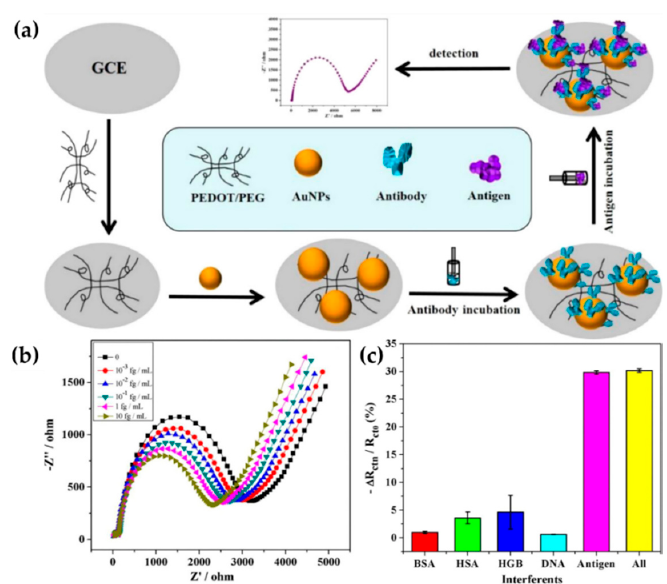
Figure 9. ( a ) Schematic illustration of of α -fetoprotein (AFP) biosensor synthesis; ( b ) impedance spectra corresponding to the biosensor with different antigen concentrations (0.01-M PBS, pH 7.4), curves from inner to outer represent 10 fg/mL, 1 fg/mL, 10 − 1 fg/mL, 10 − 2 fg/mL, 10 − 3 fg/mL AFP antigen, respectively; ( c ) responses of the AFP biosensor to bovine serum albumin (BSA) (1.0 nM), human serum albumin (HSA) (1.0 nM), hemoglobin (HGB) (1.0 nM), DNA sequence (1.0 nM), AFP antigen (1.0 fg/mL) and a mixture of all the above substances, respectively. Adapted with permission from reference [41]. Copyright © 2016 Elsevier B.V.